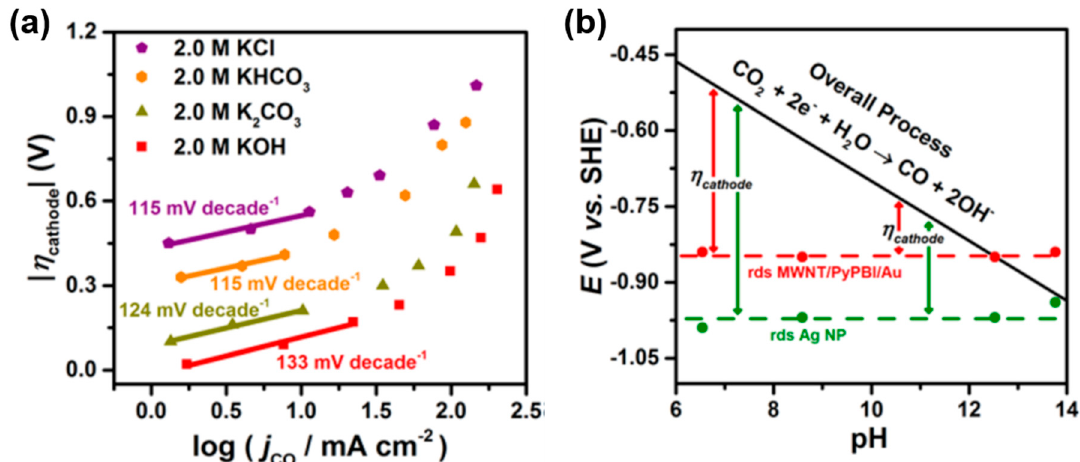
Figure 13. The results of electrolyte dependence for the electrochemical CO 2 reduction reaction. ( a ) Tafel plots when using various electrolytes (KCl, KHCO 3 , K 2 CO 3 , and KOH). ( b ) Diagram of the relationship between the onset cathodic potential and pH values. Reprinted with permission from the authors of [32]. Copyright (2018) American Chemical Society.